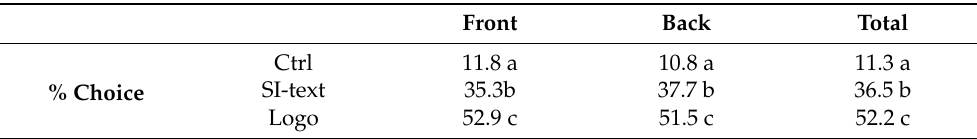
Table 2. Percentage of choice among the three evaluated labels. Two hundred and four consumers evaluated the front-labels and the other 204 the back-labels. Front Back Total Ctrl % Choice